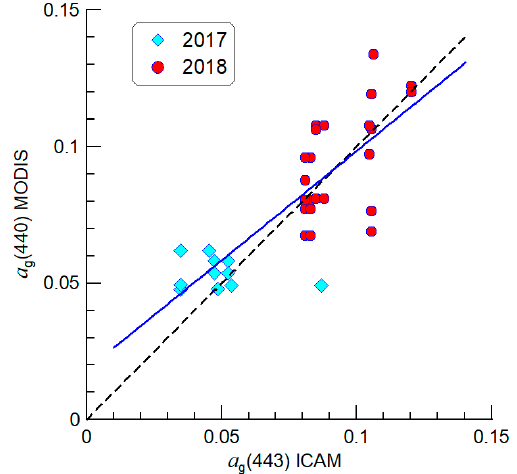
Figure 8. Scatterplot of the a g (443) values, calculated from satellite MODIS data, relative to the values measured by ICAM.